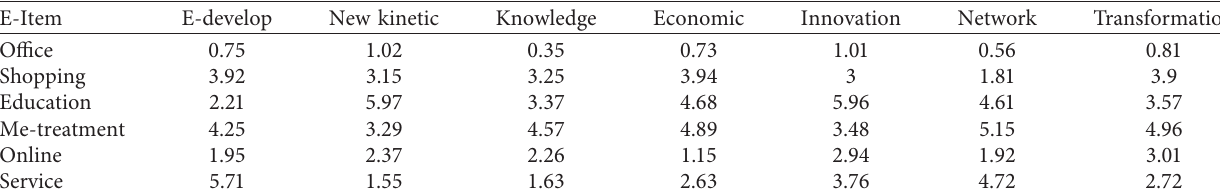
Table 7: The influence of total factor productivity.